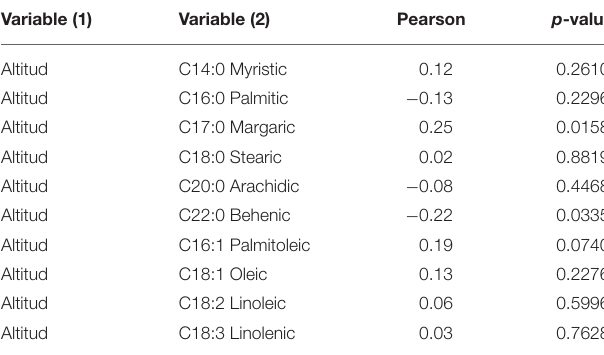
TABLE 6 | Pearson’s correlation of 30 ecotypes between the height of sample collection in meters above the sea level and the the fatty acid